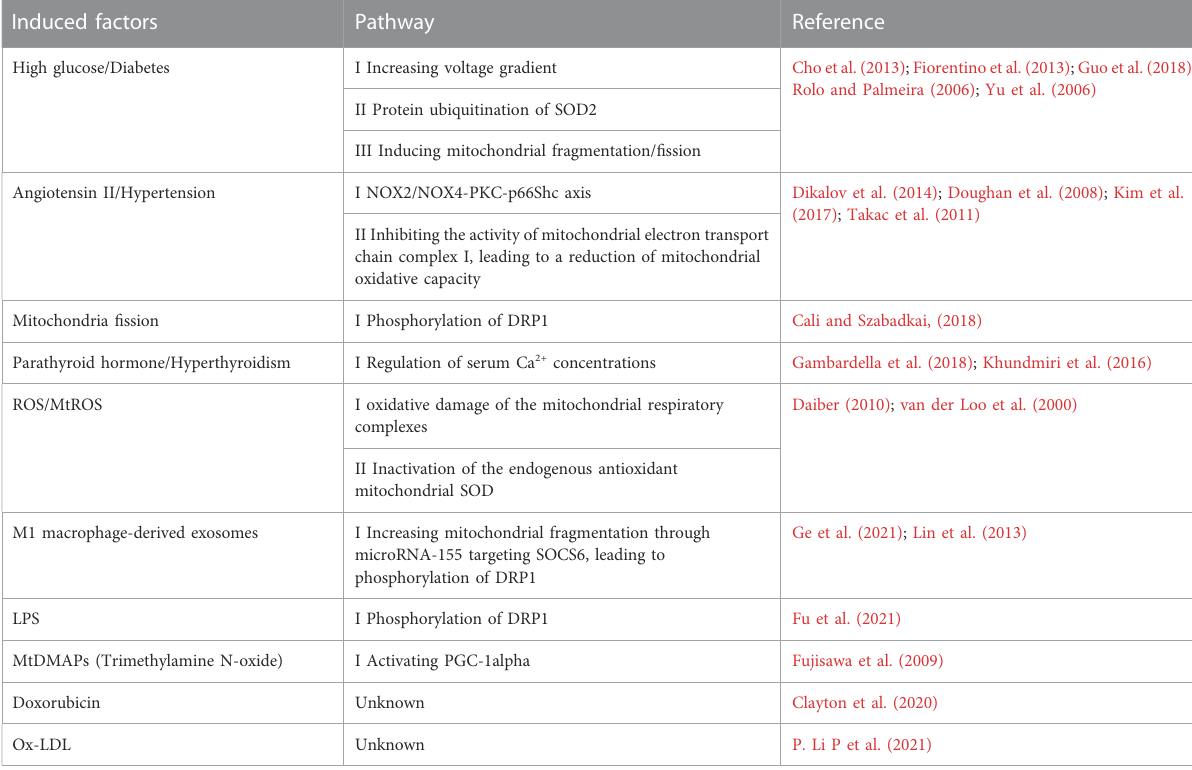
TABLE 1 The induced factors of excessive mtROS in endothelial